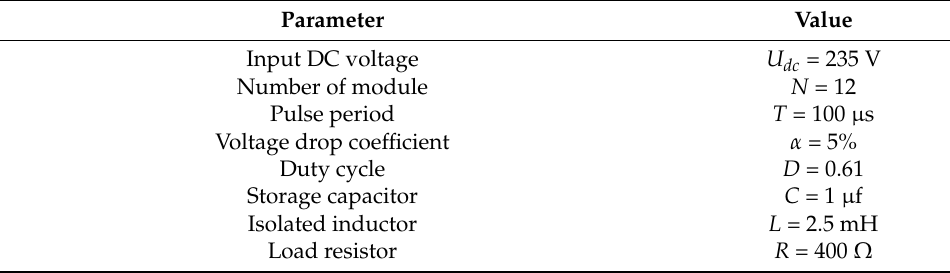
Table 2. Proposed topology simulation parameter for 10 kV